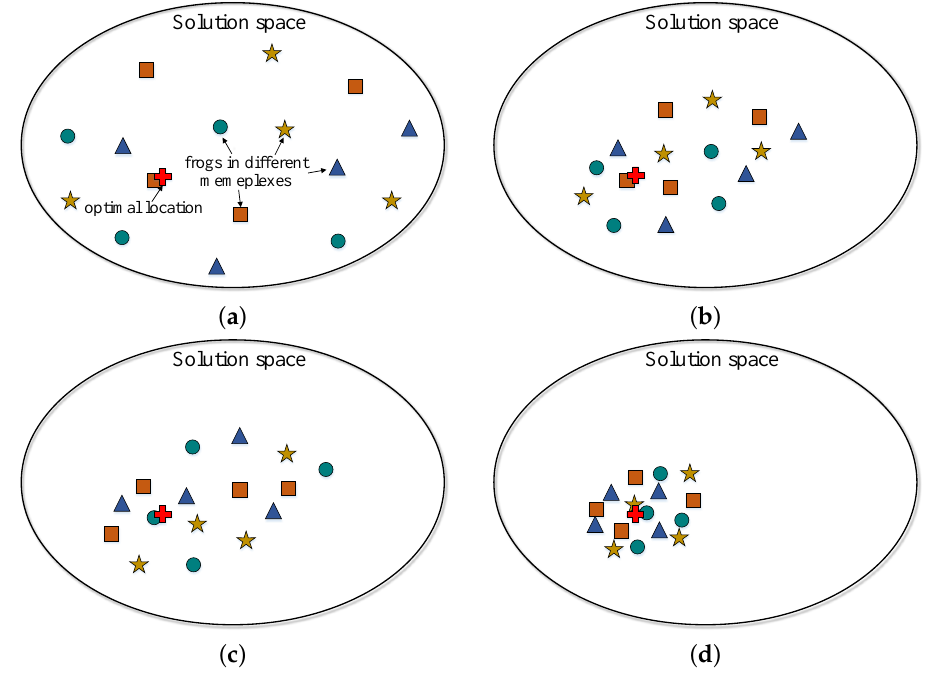
Figure 2. Illustration of SFLA. ( a ) At the beginning of Time Loop 1, 16 frogs are randomly generated and divided into four memeplexes (denoted by triangle, square, pentagon, and circle); ( b ) at the end of Time Loop 1, each memeplex is evolved; ( c ) at the beginning of Time Loop 2, all frogs are mixed and re-divided; ( d ) at the end of Time Loop 2, each memeplex is